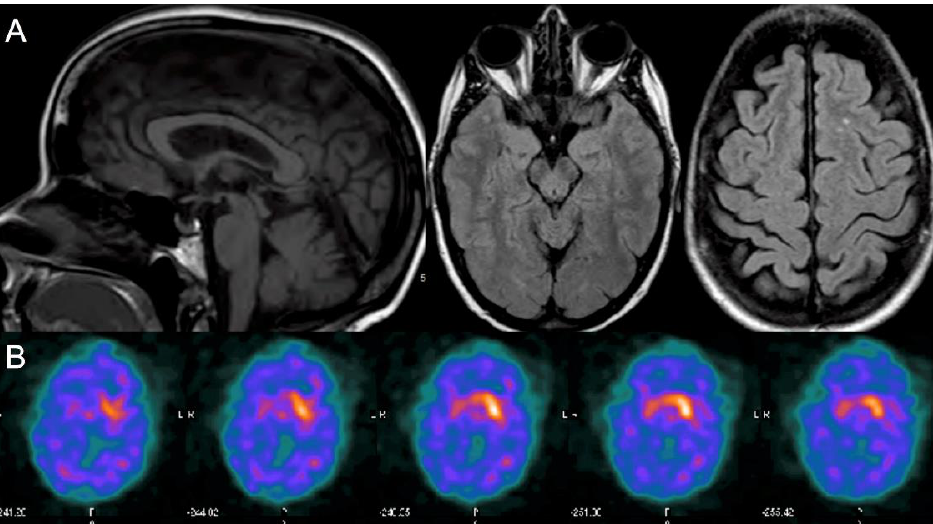
Figure 1. Brain magnetic resonance imaging (MRI) and single-photon emission computed tomog- raphy (DaTscan) obtained four years after symptom onset. ( A ) Brain MRI Left panel: mid-sagittal T1-weighted sequence with mild vermal cerebellar atrophy and midbrain atrophy (midbrain anteroposterior diameter, 8.6 mm; midbrain-to-pons ratio 0.54) [6] ; central panel: axial T2 FLAIR sequence showing mild tegmental midbrain atrophy; right panel: axial T2 FLAIR sequence showing two small white matter hyperintensities. ( B ) DaTscan showed asymmetric (right > left), abnormally decreased uptake in the bilateral putamen and right caudate.